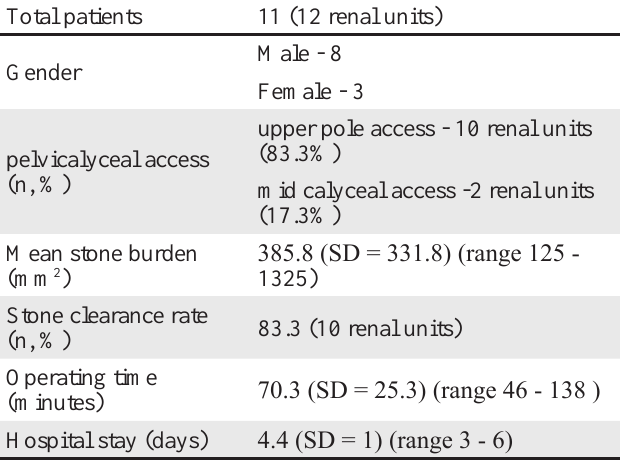
Table 1. Demographic profile and perioperative variables of the patients